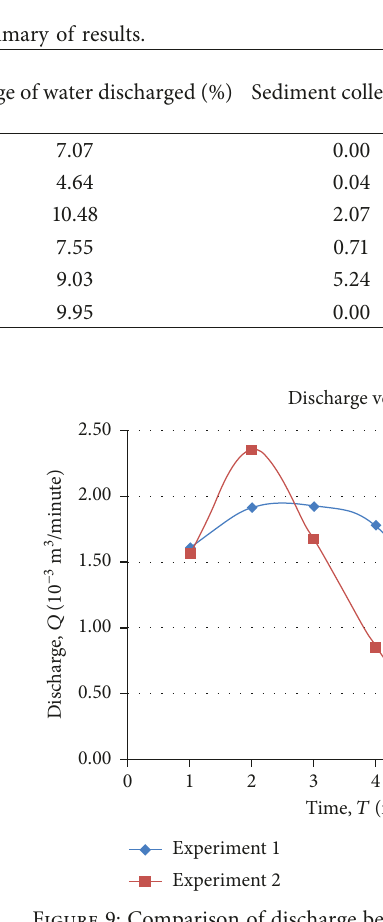
Figure 9: Comparison of discharge between Experiments 1 and 2 for the first 7